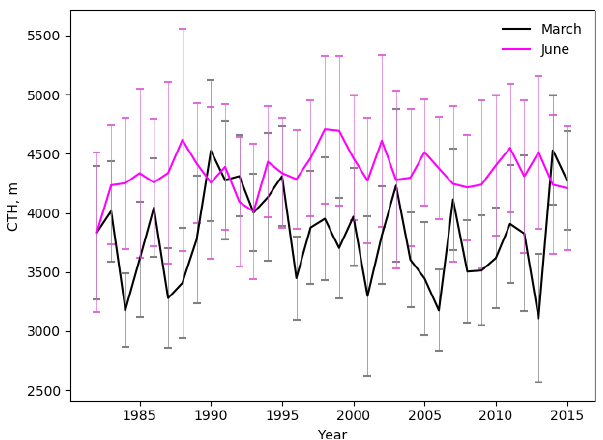
Figure 4. Monthly average CTH over the entire region 1982 to 2015 for March (black) and June (magenta) from CLARA-A2 with